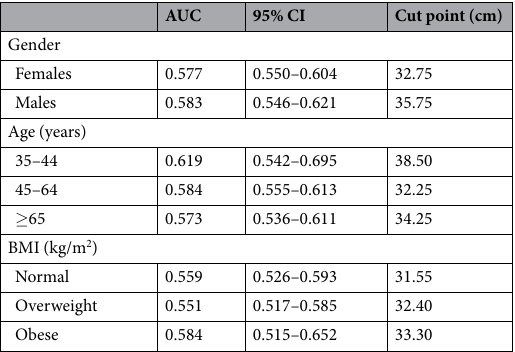
Table 4. Gender, age and BMI-specific areas under the receiver operating characteristic curves showing the ability of neck circumference to identify subjects with hypertension. BMI, body mass index; AUC, areas under the receiver operating characteristic curves; CI, confidence